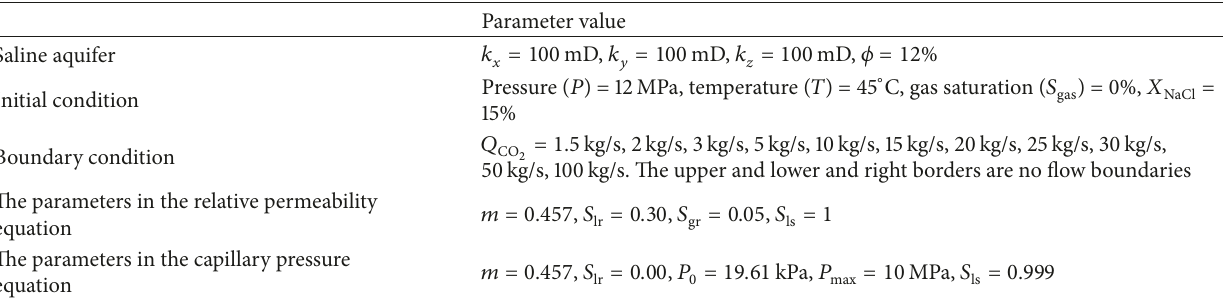
Table 6: The parameters of the radial model